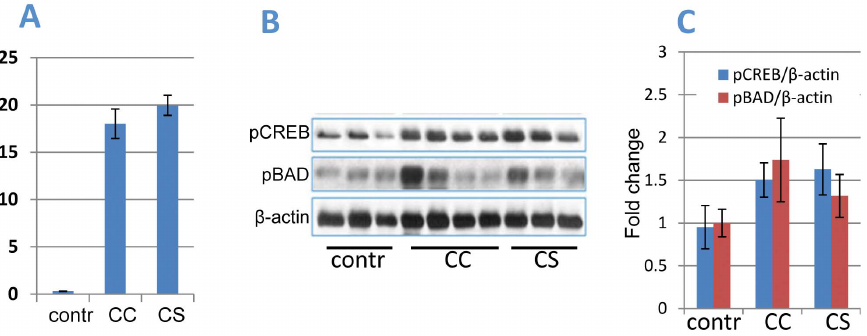
Figure 3. Surgical castration increases epinephrine and activates the PKA/BAD signaling pathway. A) Epinephrine levels in plasma of castrated mice either left intact or subjected to immobilization stress for 1 h. Contr=intact mice; CC=castrated and not stressed (calm); CS=castrated and stressed. B, C) Increased BAD and CREB phosphorylation in prostates of castrated mice. (B) Western blot and (C) densitometric analysis of Western blots of proteins extracted from anterior prostate glands of same mice as in (A). At least 3 mice were used for each data point. Error bars represent SD from the average. Contr=intact mice; CC=castrated and not stressed (calm); CS=castrated and stressed.